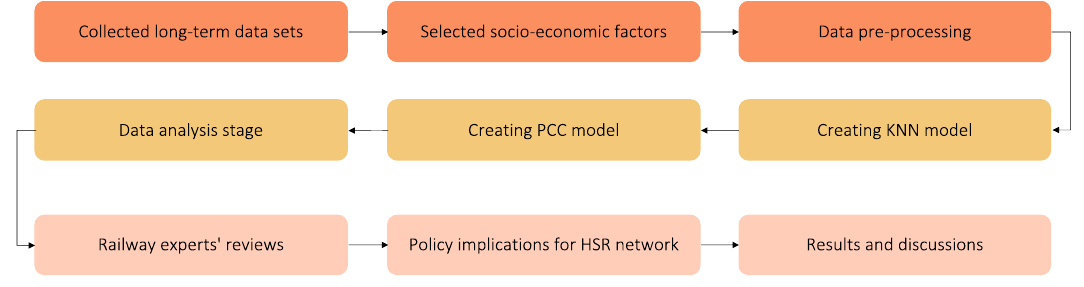
Figure 1. An overview of research methodology.